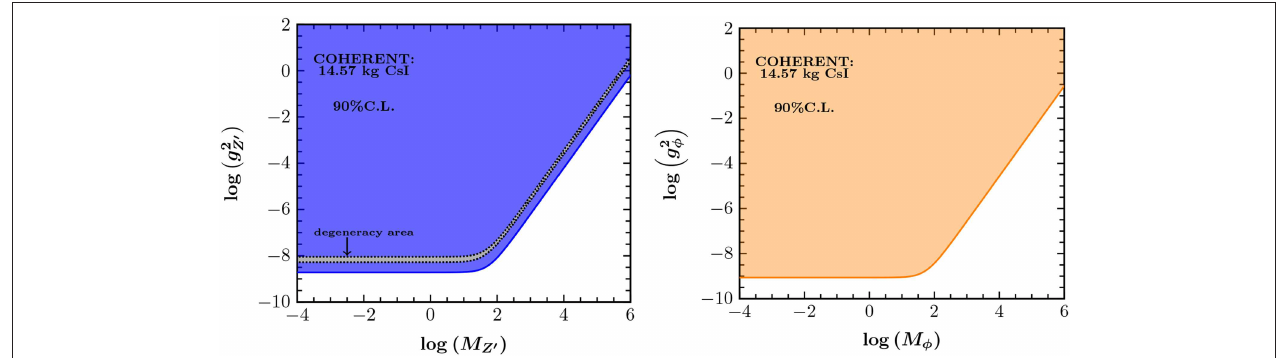
FIGURE 12 | Excluded regions at 90% C.L. by the COHERENT experiment assuming simplified scenarios involving a Z ′ vector mediator (Left panel) and a φ scalar mediator (Right panel) . The mediator masses are in units of MeV. Figure adapted from Papoulias and Kosmas [21] under the terms of the Creative Commons Attribution 4.0 International